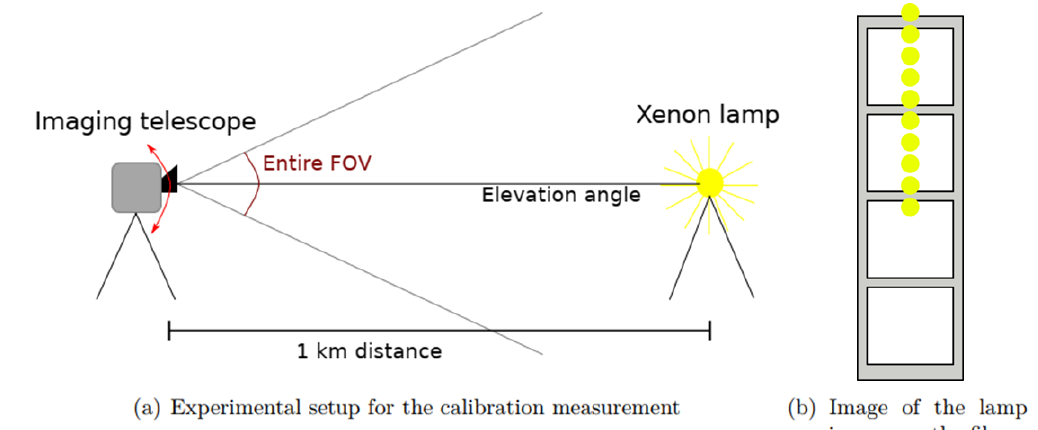
Figure 3. Scheme of calibration measurement procedure (Ostendorf, 2017).